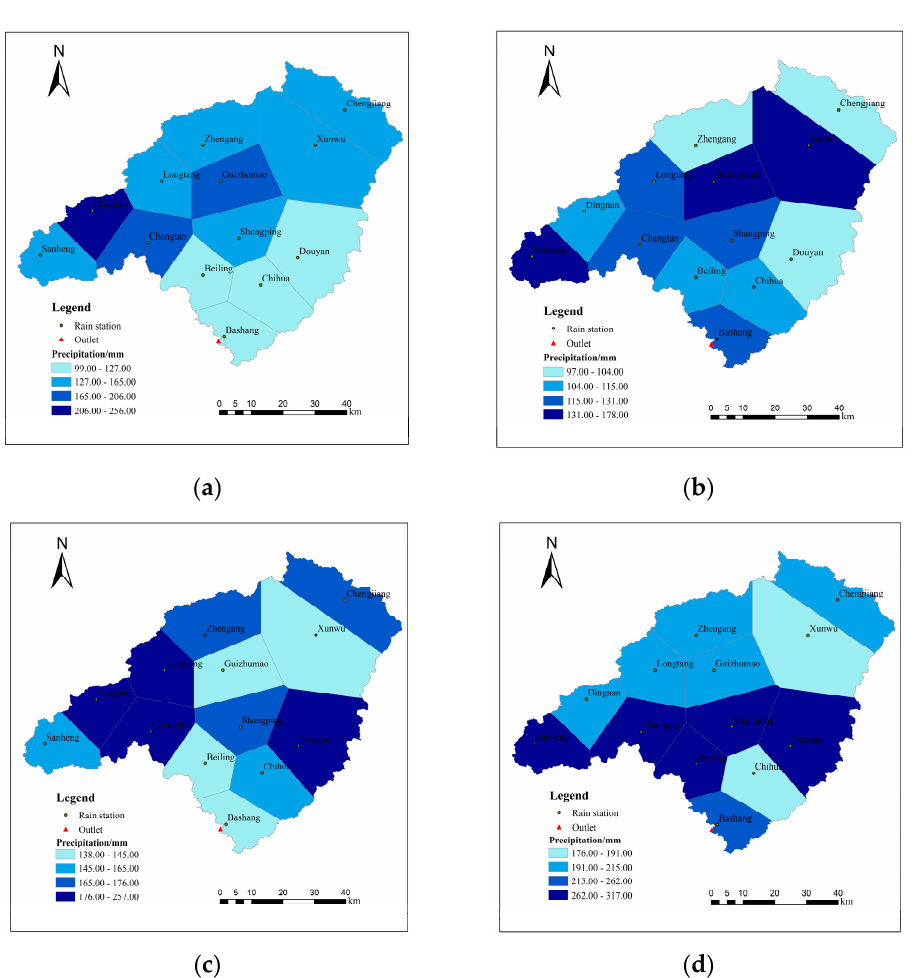
Figure 2. Rainfall distributions of randomly selected floods with flood numbers: ( a ) 2011051315; ( b ) 2014051901; ( c ) 2016042408; and ( d ) 2019060702. Table 1. Information on the studied flood events. Flood Event